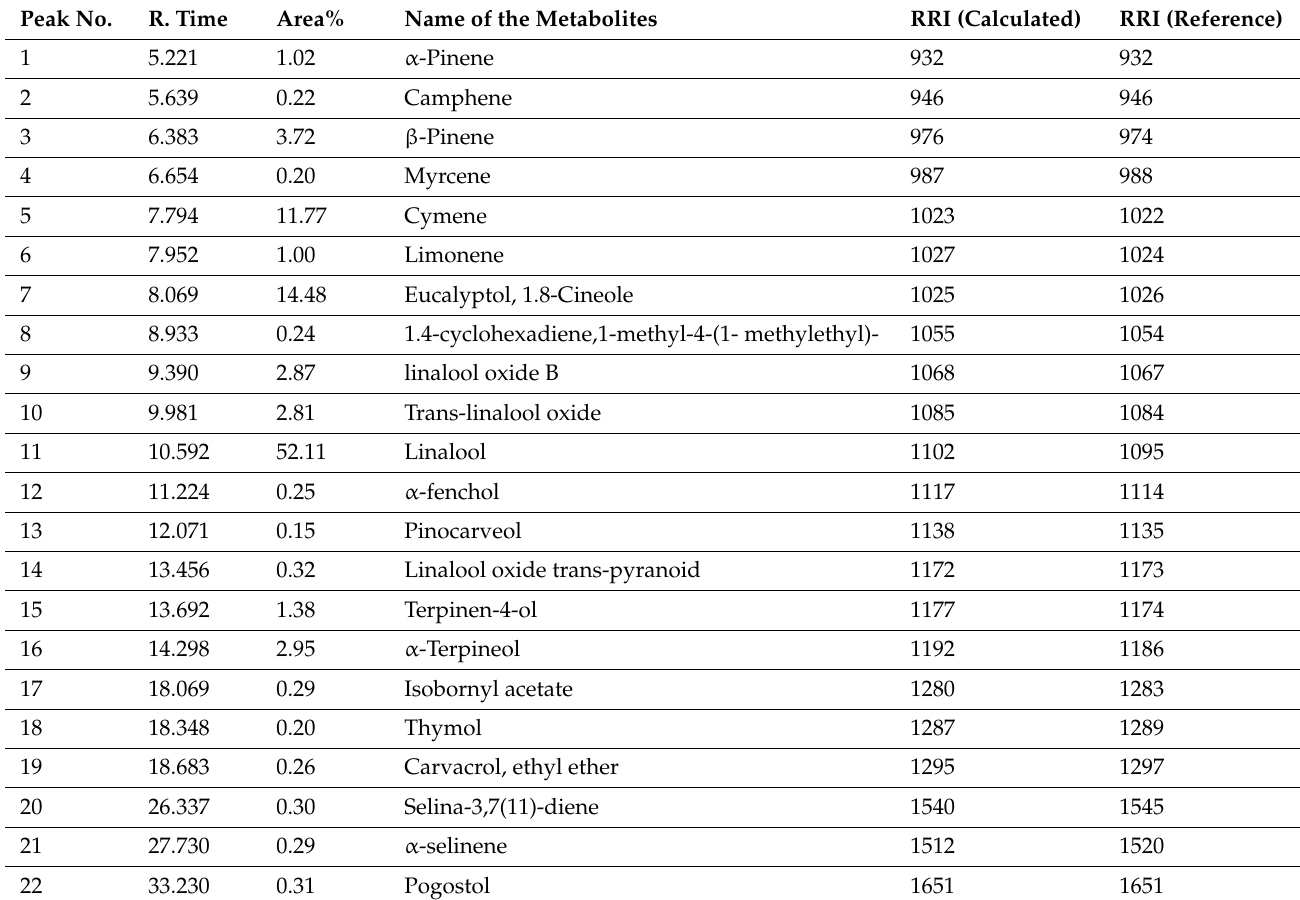
Table 1. List of major phytochemicals identified through GC-MS